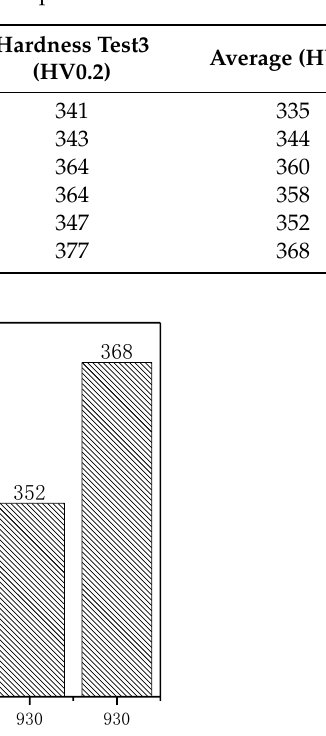
Table 4. Hardness of di ff erent normalizing temperature.